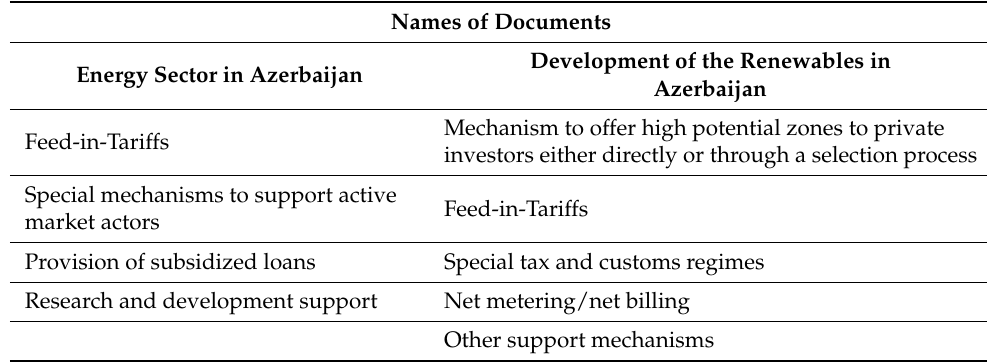
Table 15. Support mechanisms announced by the Ministry of Energy of